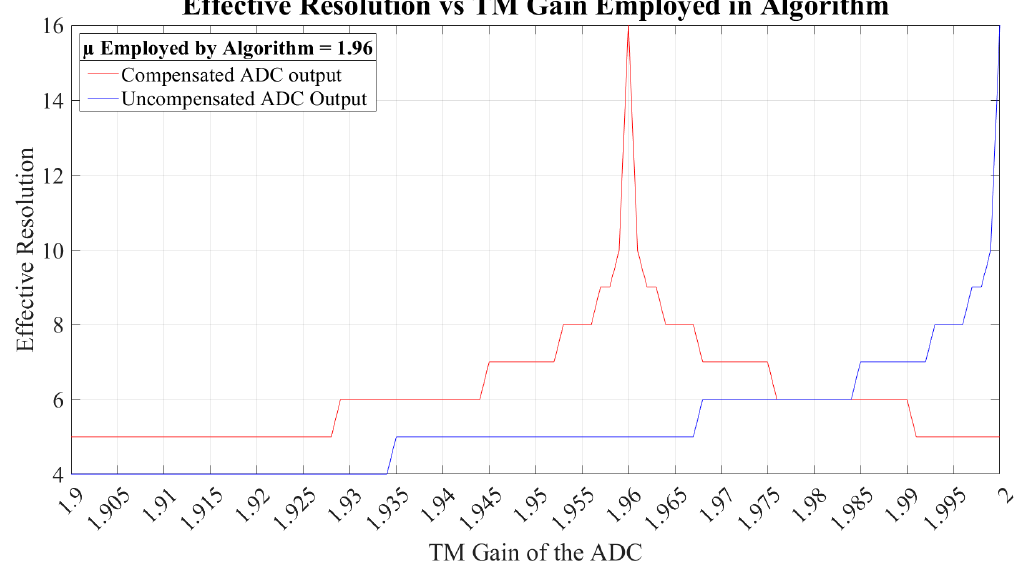
Figure 20. Sensitivity analysis results from a 16-stage TM-based ADC.